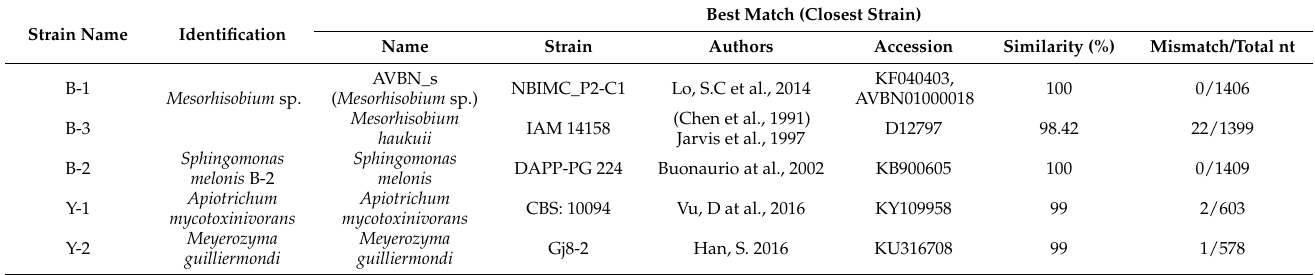
Table 1. Identification of microorganisms efficient for the biodegradation of azo dye Acid Blue